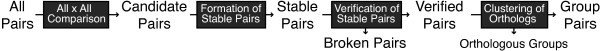
Algorithm flow chart. Boxes represent the steps of the algorithm, and arrows are the input and output data for each step.